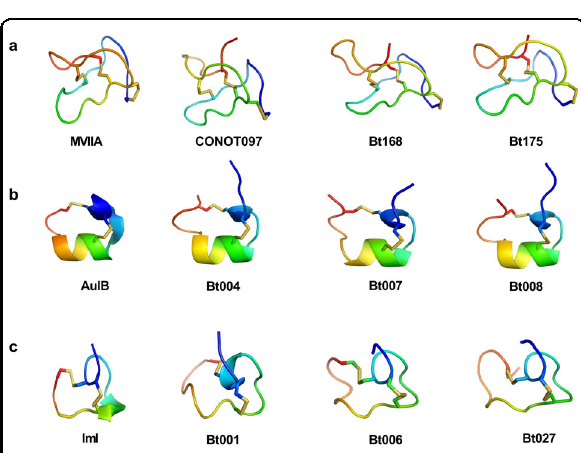
Fig. 5 Predicted stereostructures of homologous conopeptides on the basis of MVIIA. Stereostructures of MVIIA ( a ), AuIB ( b ) and ImI ( c ). Each top 3 best-hit conopeptides from homologous alignments were selected to predict stereostructures. Models of the conopeptides were built using MVIIA (PDB:1OMG), AuIB (PDB:1MXN) and ImI (PDB:2BC7) as templates in MODELLER (version 9v12). All the modeling structures were generated with PyMol. See more details about the protein sequence alignments in Table